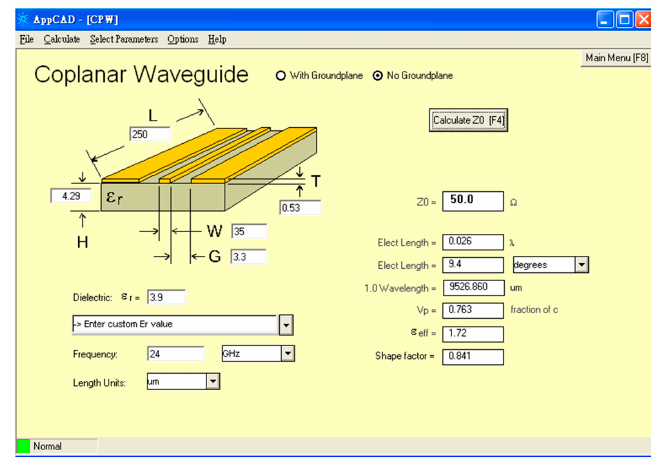
Figure 5. Simulation of characteristic impedance for the coplanar waveguide (CPW). Table. 1 Characteristics of the coplanar waveguide (CPW).